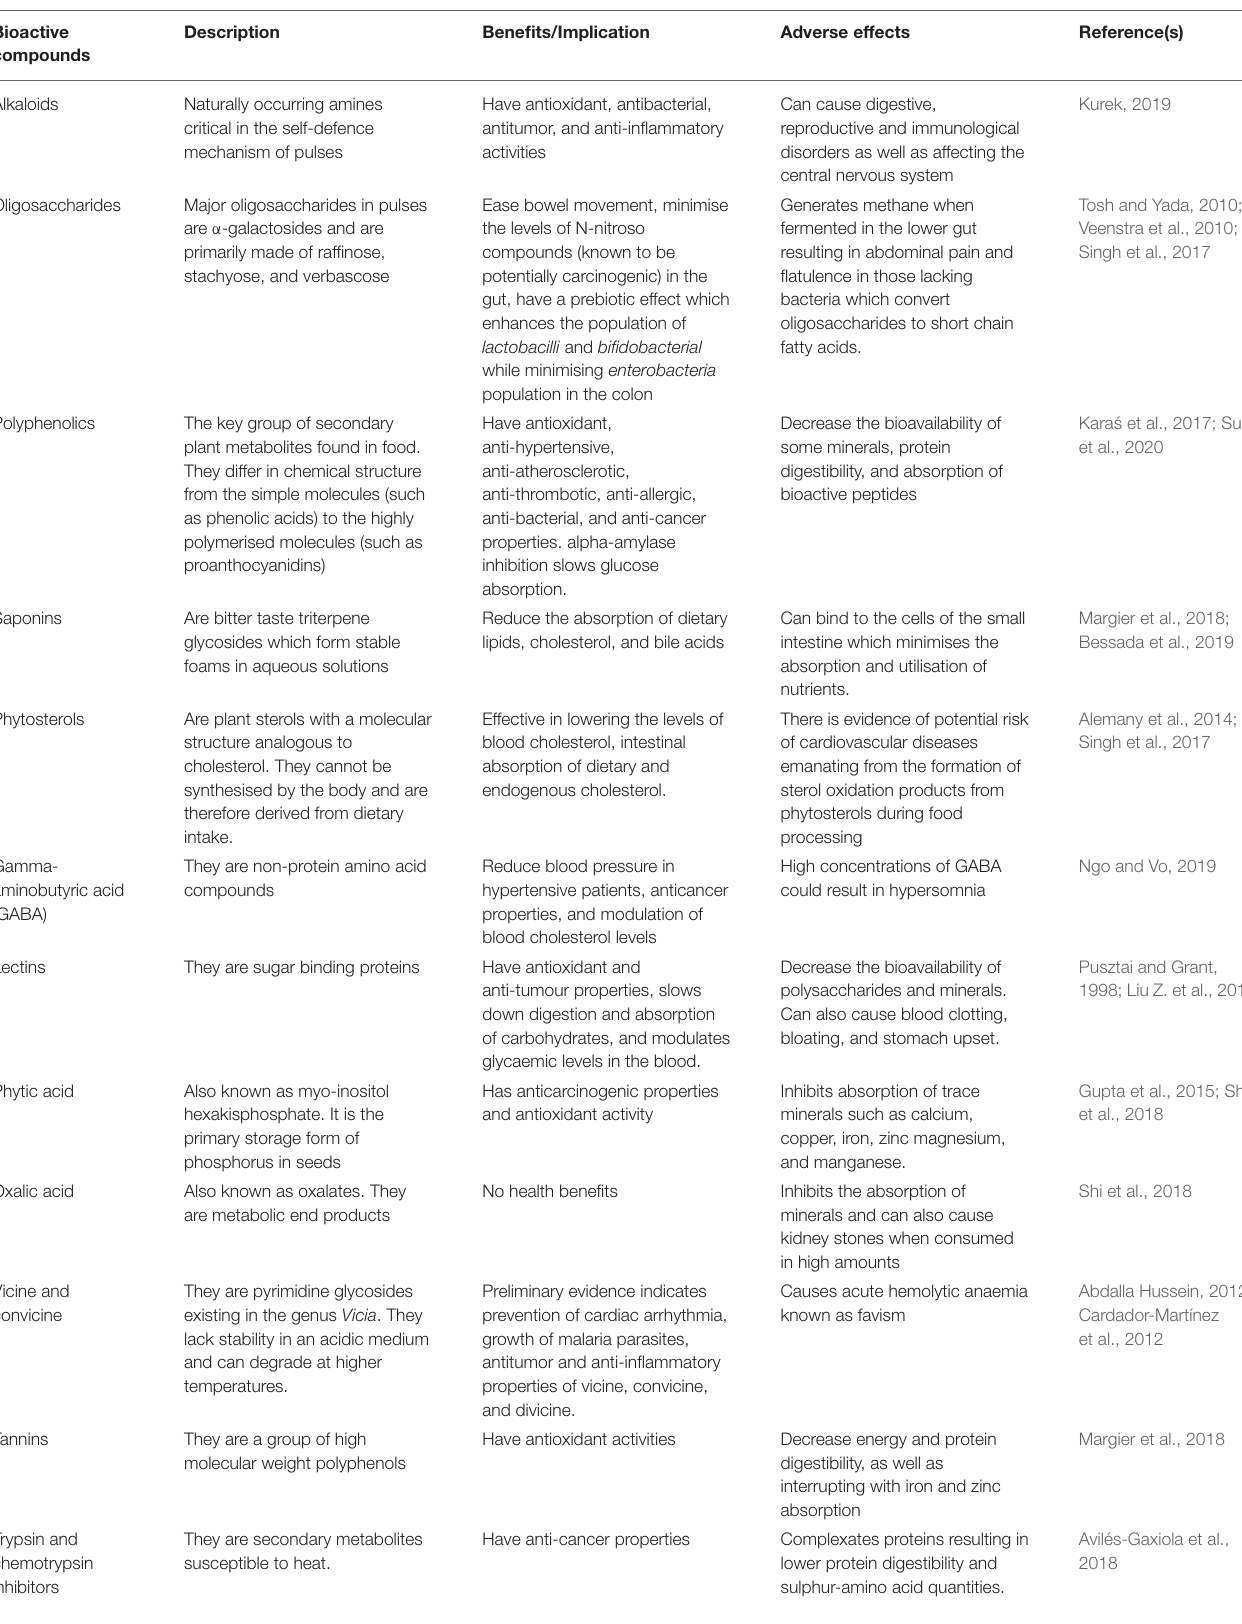
TABLE 1 | Possible benefits and/or adverse effects of some bioactive compounds present in